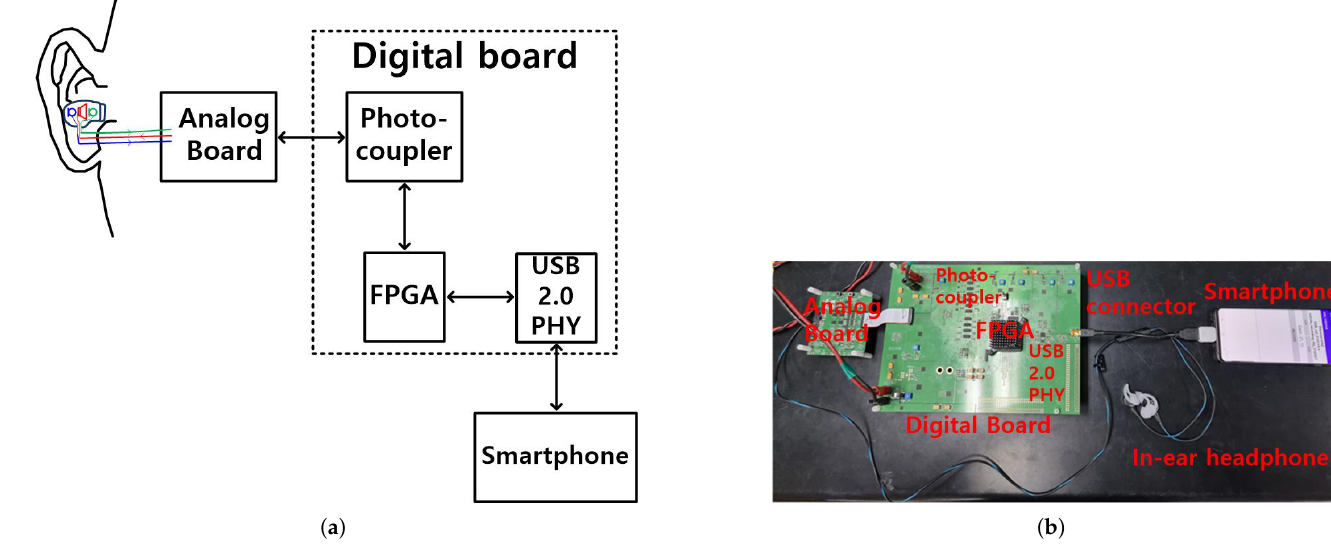
Figure 13. Measurement setup ( a ) block diagram and ( b )